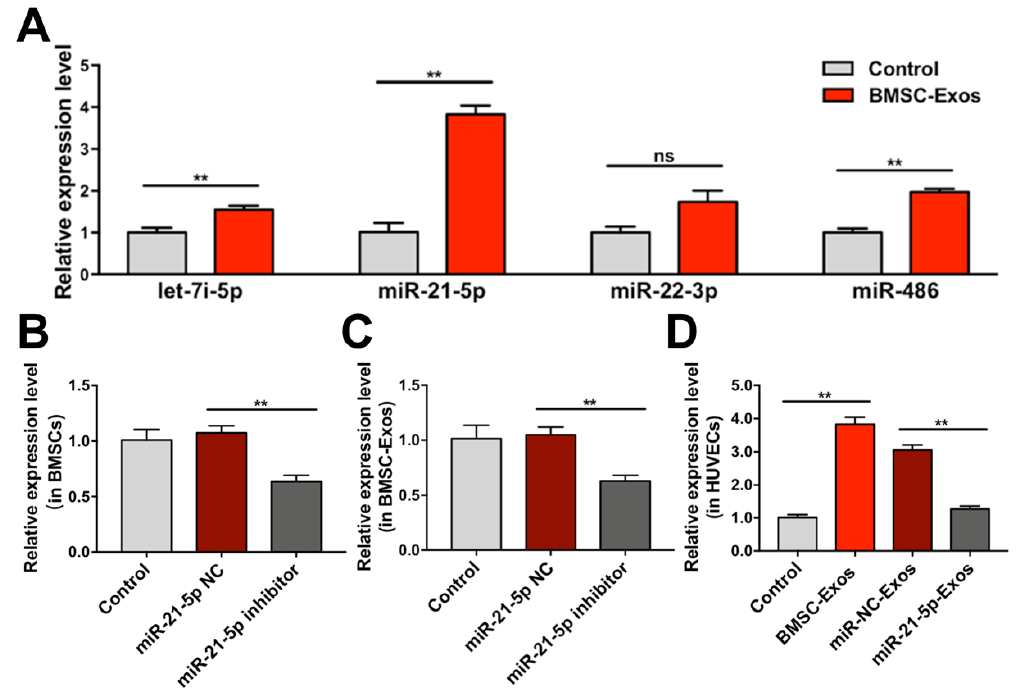
Figure 8. The expression of miRs in vitro were determined by qRT-PCR. ( A ) The expression levels of let-7i-5p, miR-21-5p, miR-22-3p and miR-486 in HUVECs treated with BMSC-Exos. ** p < 0.01. ns, not significant. ( B ) The expression levels of miR-21-5p in BMSCs after miR-21-5p inhibitor transfection. ** p < 0.01. ( C ) The expression levels of miR-21-5p in Exos derived from miR-21-5p inhibitor transfected BMSCs. ** p < 0.01. ( D ) The expression levels of miR-21-5p in HUVECs treated with Exos derived from miR-21-5p inhibitor transfected BMSCs. ** p < 0.01. n = 3/group. BMSCs, bone marrow mesenchymal stem cells; BMSC-Exos, bone marrow mesenchymal stem cell-derived exosome; miR-21-5p NC, miR-21-5p inhibitor negative control; miR-NC-Exos, Exos derived from BMSCs transfected with miR-21-5p inhibitor negative control; miR-21-5p-Exos, Exos derived from BMSCs transfected with miR-21-5p inhibitor.